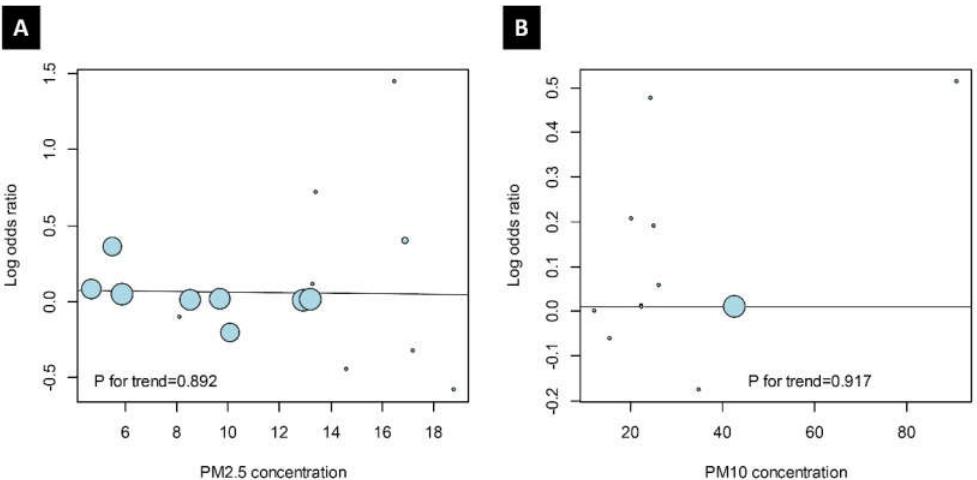
Figure 4. Trends between odds ratios and representative PM values in the ( A ) PM 2.5 and ( B ) PM 10 groups. Each circle is a study included in this article, and its area means the number of its subjects.